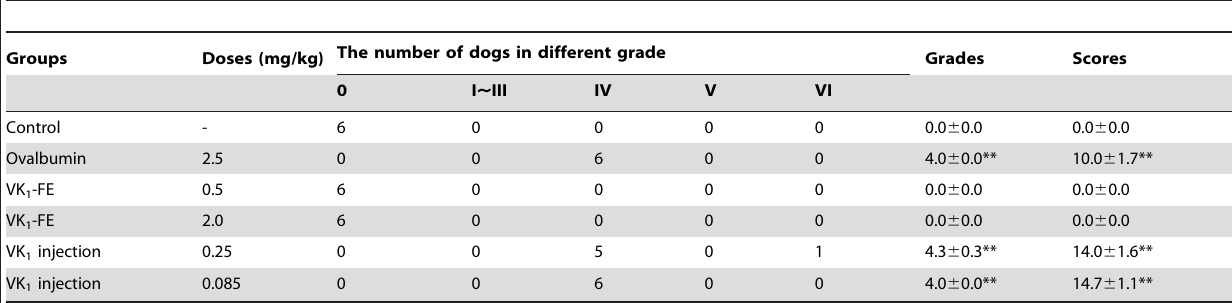
Table 4. The grades and scores of symptoms in dogs after the challenge with vitamin K 1 (VK 1 ) injection and vitamin K 1 -fat emulsion (VK 1 -FE).